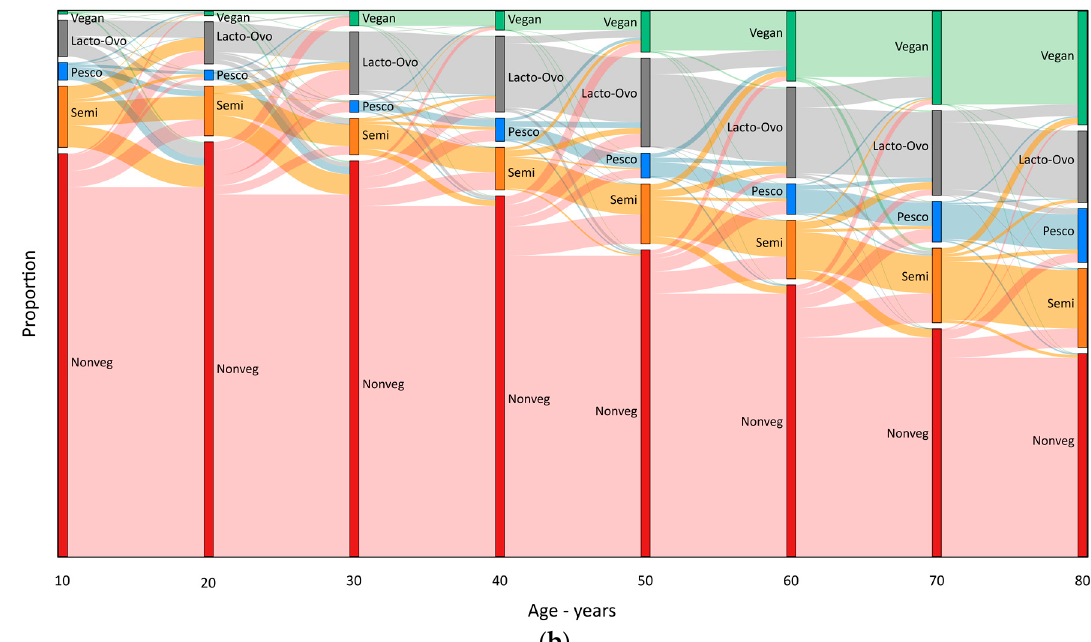
Figure 4. ( a ) Transition of vegetarian dietary patterns by decade for the non-Black 80+ years of age birth cohort ( n = 4935). Vegan, Lacto-Ovo, Pesco, Semi, and Nonveg10, 20, 30, 40, 50, 60, 70 and 80 represent the proportion of individuals who were vegans, lacto-ovo vegetarians, pesco vegetarians, semi vegetarians and non-vegetarians at age 10 to 80, respectively. The width of transition lines indicate the proportions of the population involved; ( b ) Transition of vegetarian dietary patterns by decade for the Black 80+ years birth cohort ( n = 357). Vegan, Lacto-Ovo, Pesco, Semi, and Non-veg 10, 20, 30, 40, 50, 60, 70 and 80 represent the proportion of individuals who were vegans, lacto-ovo vegetarians, pesco vegetarians, semi vegetarians and non-vegetarians at ages 10 to 80, respectively. The width of transition lines indicate the proportions of the population involved.